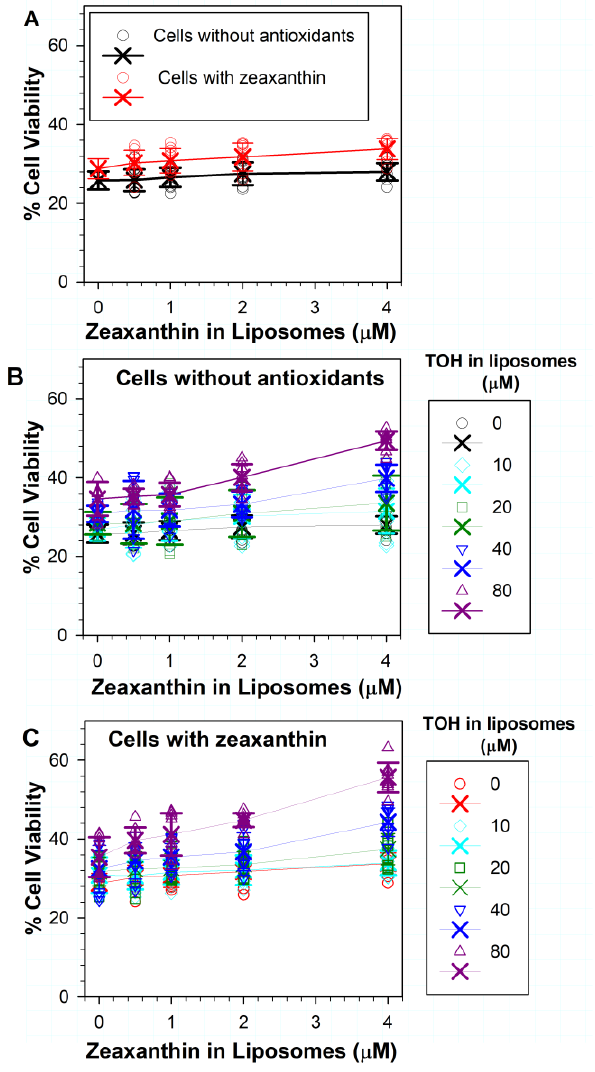
Figure 4. ( A ) Effects on ATR phototoxicity of different concentrations of zeaxanthin in liposomes to ARPE-19 cells supplemented with zeaxanthin and without zeaxanthin. ( B ) Effects on phototoxicity of different combinations of zeaxanthin and α -tocopherol (TOH) in liposomes to ARPE-19 cells not supplemented with antioxidants. ( C ) Effects on phototoxicity of different combinations of zeaxanthin and α -tocopherol in liposomes to ARPE-19 cells supplemented with zeaxanthin. The symbols represent the viability of cells in independent experiments, the crosses represent the means, while the error bars show SDs (the individual data points from experiments with no antioxidants in liposomes are shown only in Figure 3; N for each experiment with antioxidants in liposomes was 8). Other experimental conditions as in Figure